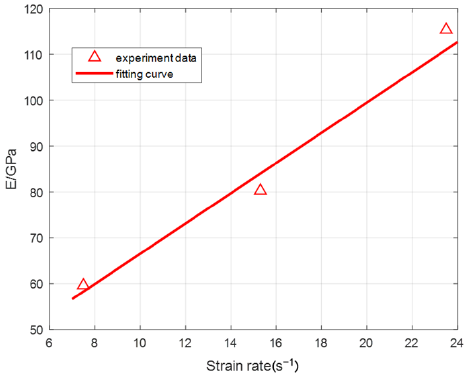
Figure 13. The relationship between elastic modulus and strain rate.